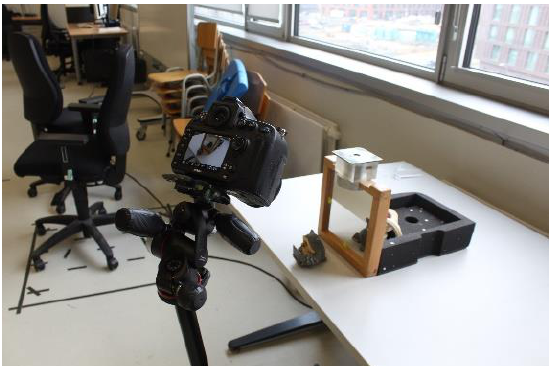
Figure 5: Image-Based Modelling experimental setup